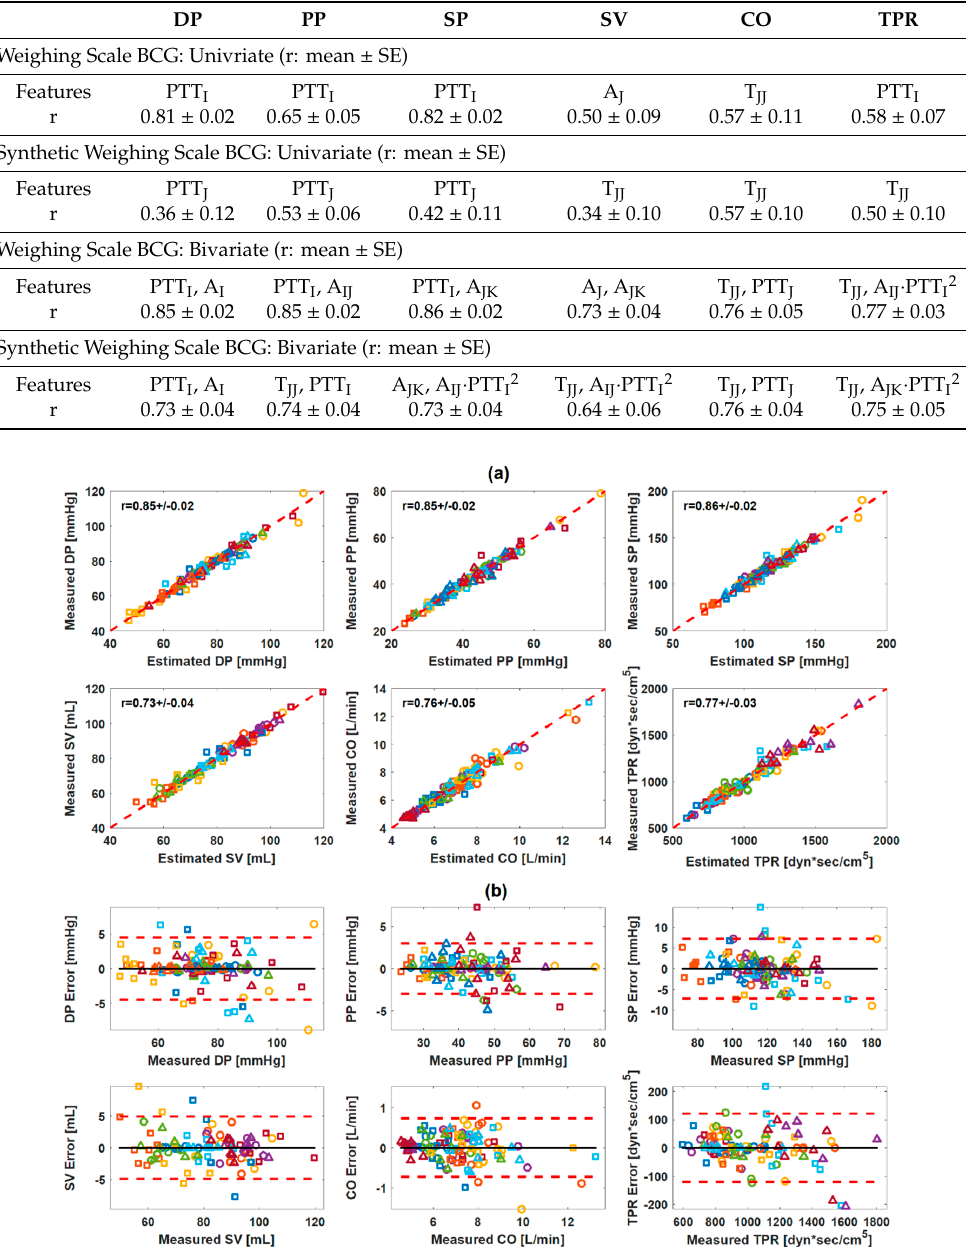
Table 3. Representative univariate and bivariate regression models associated with weighing scale ballistocardiogram (BCG) and synthetic weighing scale BCG transformed from armband BCG. DP PP